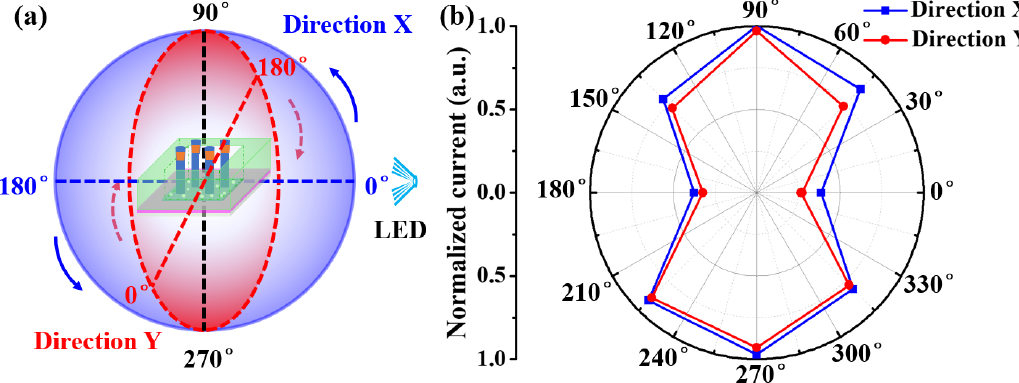
Figure 5. ( a ) Schematic illustration of the method for omnidirectional (360°) detection; ( b ) relative responsivity of the transparent PD-B with different rotation angles.